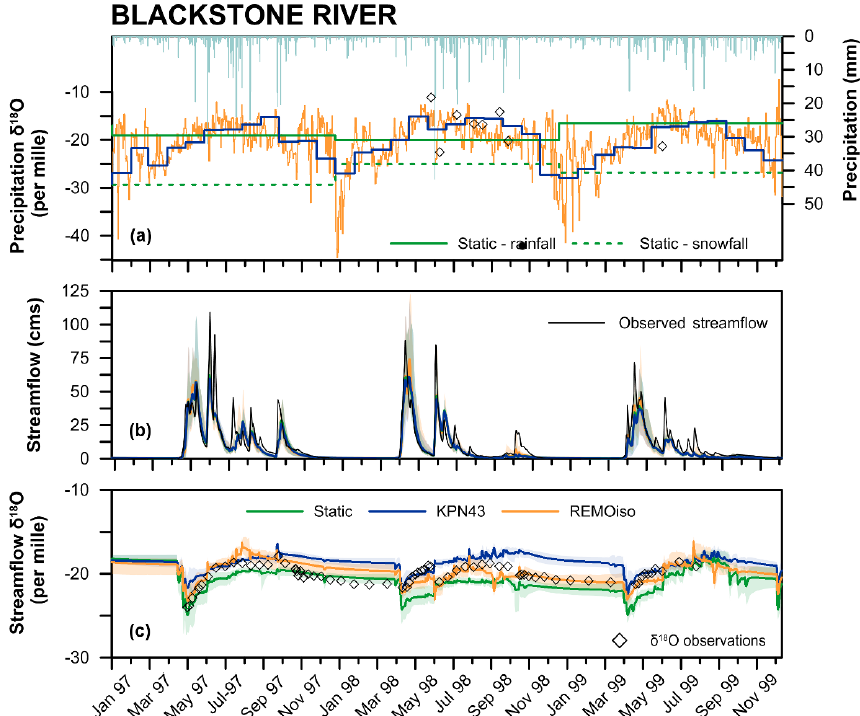
Figure 4. Input and behavioural simulations for Blackstone, including (a) KPN43, REMOiso, and static δ 18 O ppt input time series and daily precipitation, and simulated (b) mean daily streamflow and uncertainty bounds and (c) mean daily δ 18 O SF and uncertainty bounds, for KPN43, REMOiso, and static driven model calibrations. δ 18 O ppt input-specific uncertainty bounds are represented as the shaded regions, with shading colour corresponding to δ 18 O ppt